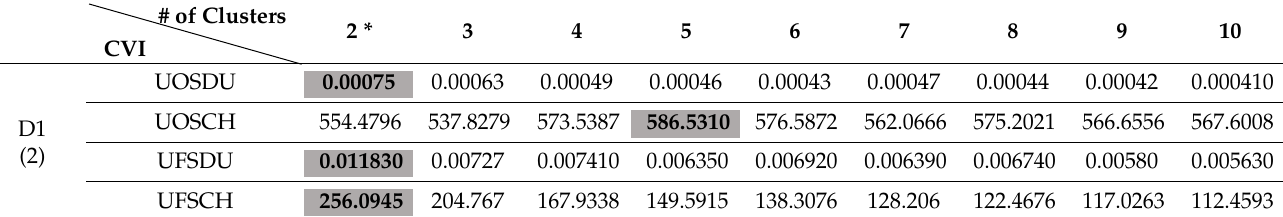
Table 2. Performance results for D1.